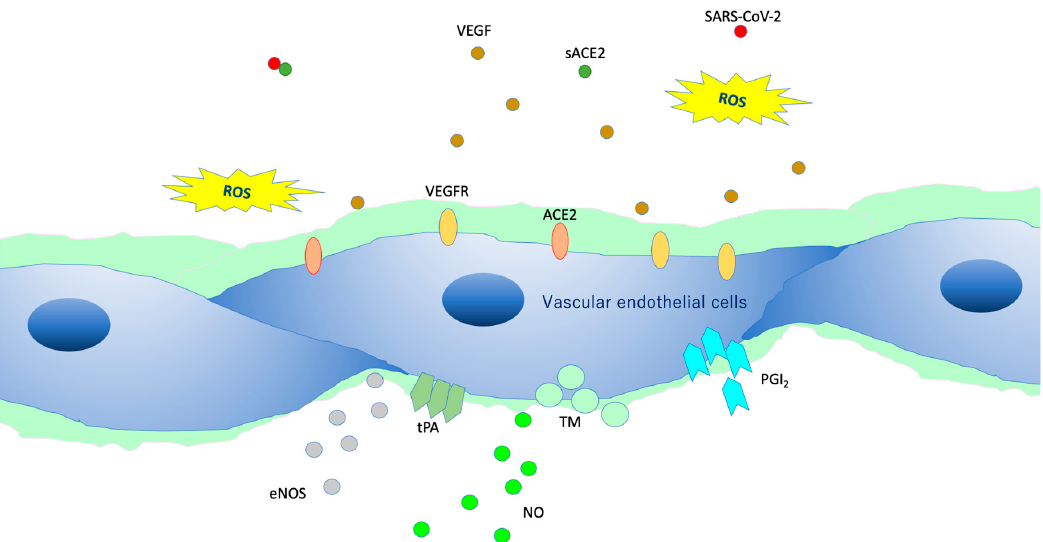
Figure 7. Intact vascular endothelial glycocalyx (VEGLX). When vascular endothelial cells are covered enough with healthy VEGLX, even if severe acute respiratory coronavirus 2 (SARS-CoV-2) enters the body, it could be neutralized by the effects of appropriate reactive oxygen species (ROS) and soluble angiotensin-converting enzyme 2 (sACE2), and it may be possible to prevent the virus entry into the vascular endothelium. VEGF, vascular endothelial growth factor; VEGFR, VEGF receptors; NO, nitric oxide; eNOS, endothelial NO synthase; TM, thrombomodulin; tPA, tissue plasminogen activator; PGI2, prostacyclin.